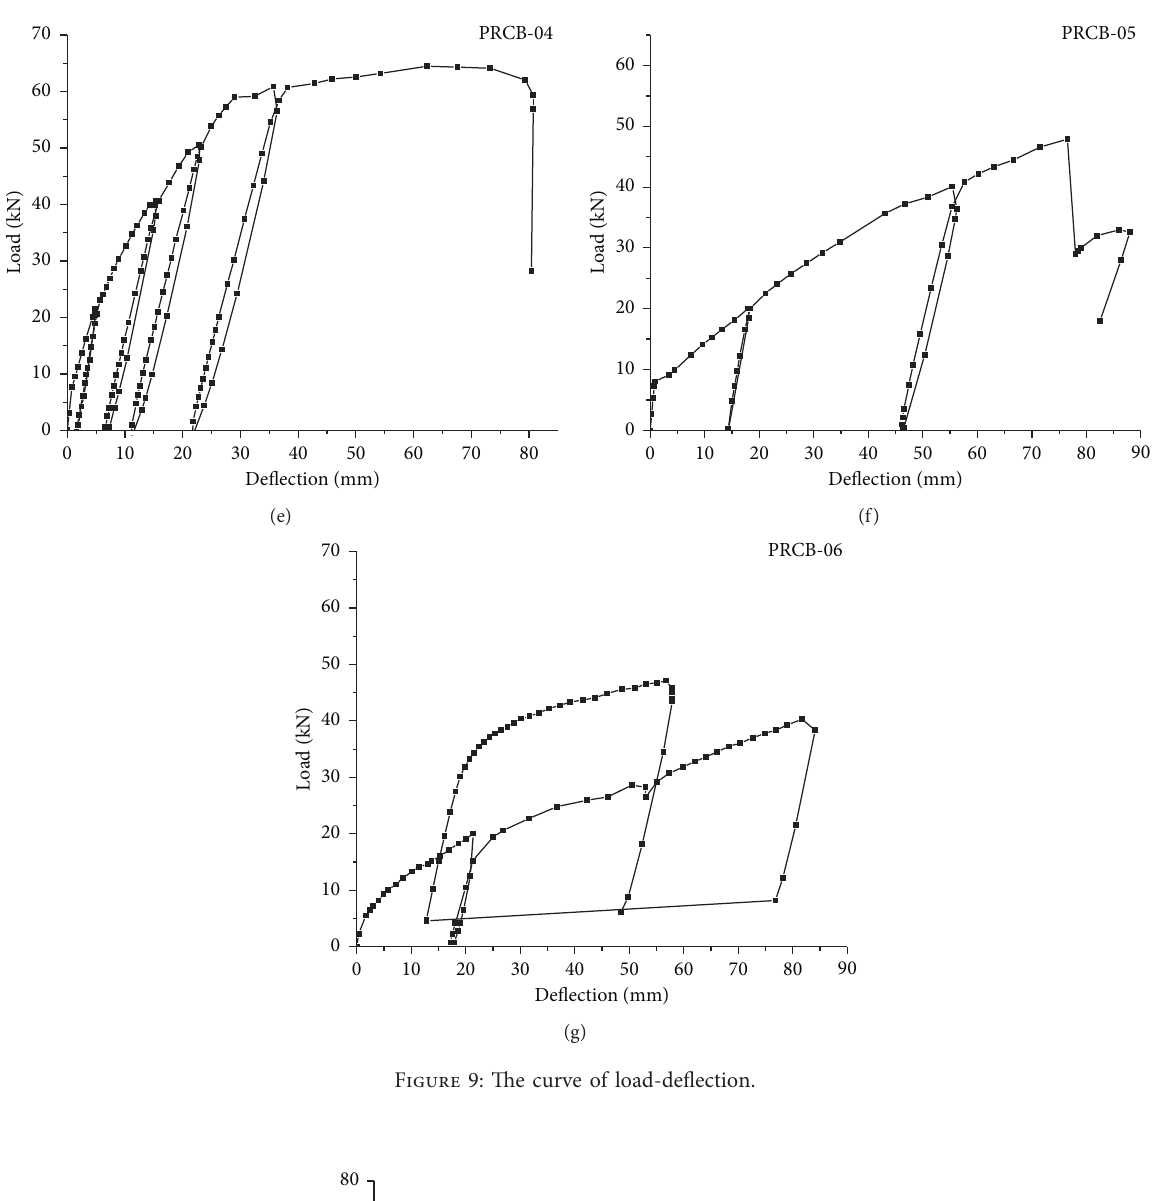
Figure 9: The curve of load-deflection.